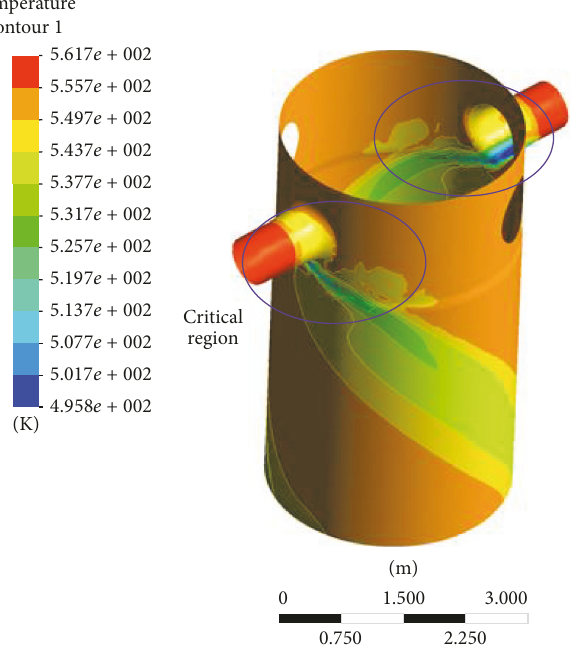
Figure 16: Temperature distribution of the RPV wall at 150